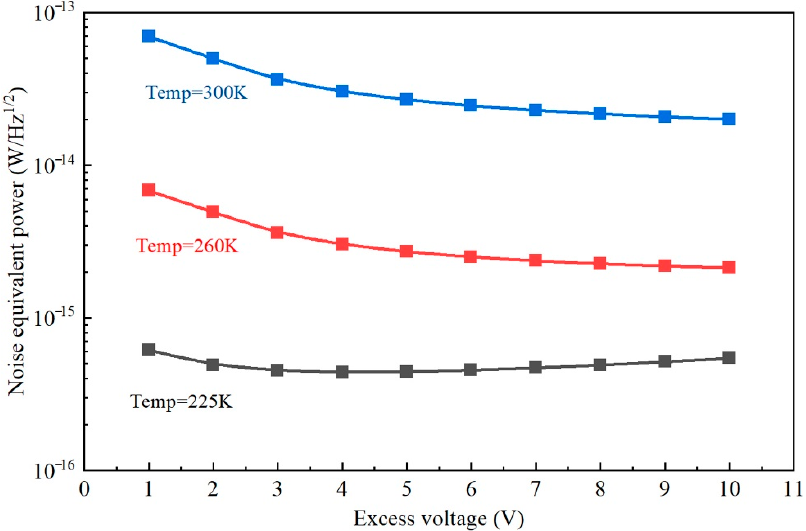
Figure 10. The dependence of the noise equivalent power (NEP) on the excess 图 10